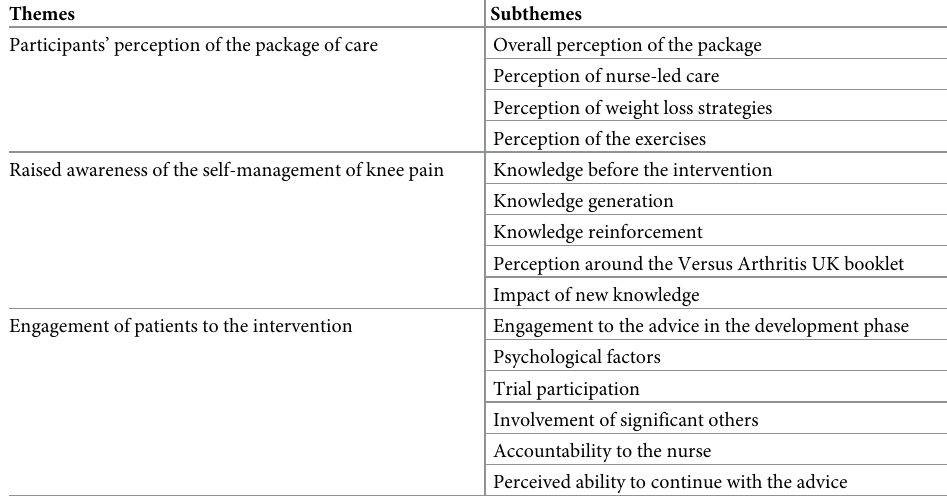
Table 2. Themes and subthemes emerging from the